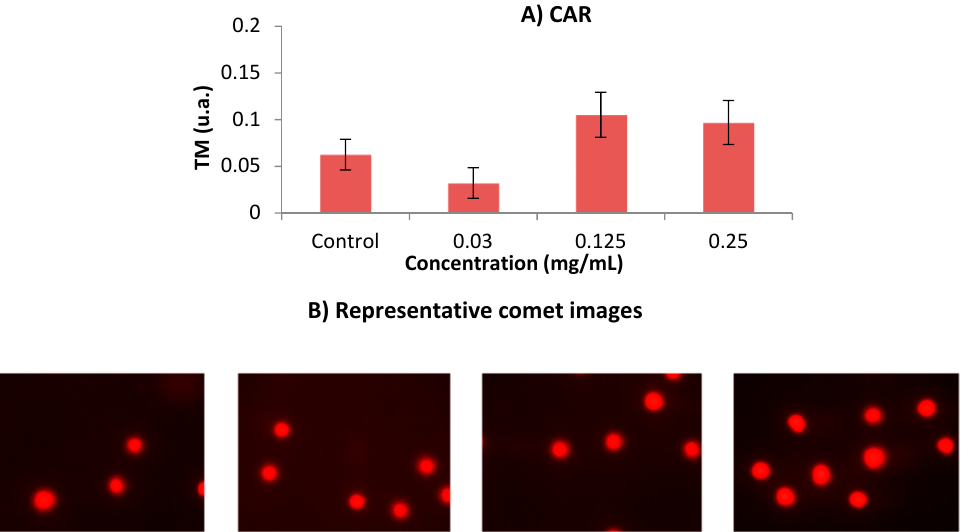
Figure 3. Internucleosomal DNA fragmentation after 5 h of HL-60 cells treated with CAR. Letters M and C mean weight size marker and negative control (RPMI), respectively, and lyophilised blond beer (62.5 mg/mL) has been used as a routine positive control (PC).